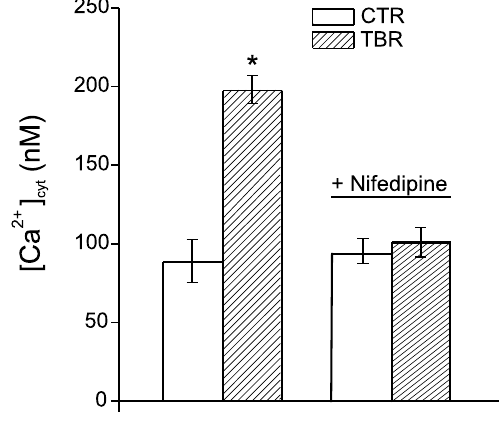
Fig. 3 – The increase in cytosolic free Ca 2 + concentration ([Ca 2 + ] cyt ) in TBR lymphocytes is prevented by nifedipine. CTR (white bars) and TBR lymphocytes (hatched bars) were incubated for 3 h in RPMI 1640 medium in the absence or presence of 10 µ M nifedipine as indicated in the figure. *p < 0 . 01 vs.